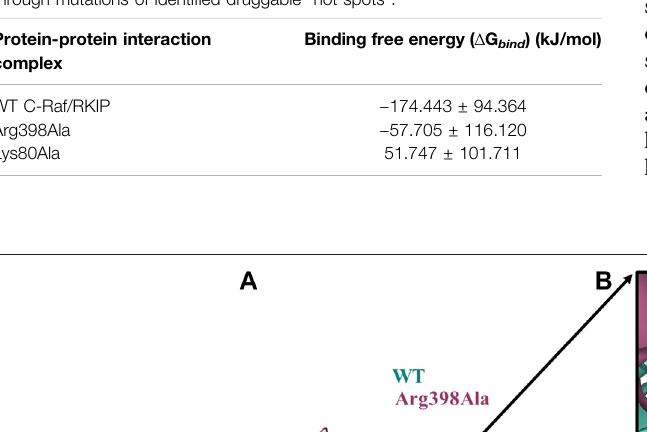
Binding free energy ( Δ G bind ) (kJ/mol)